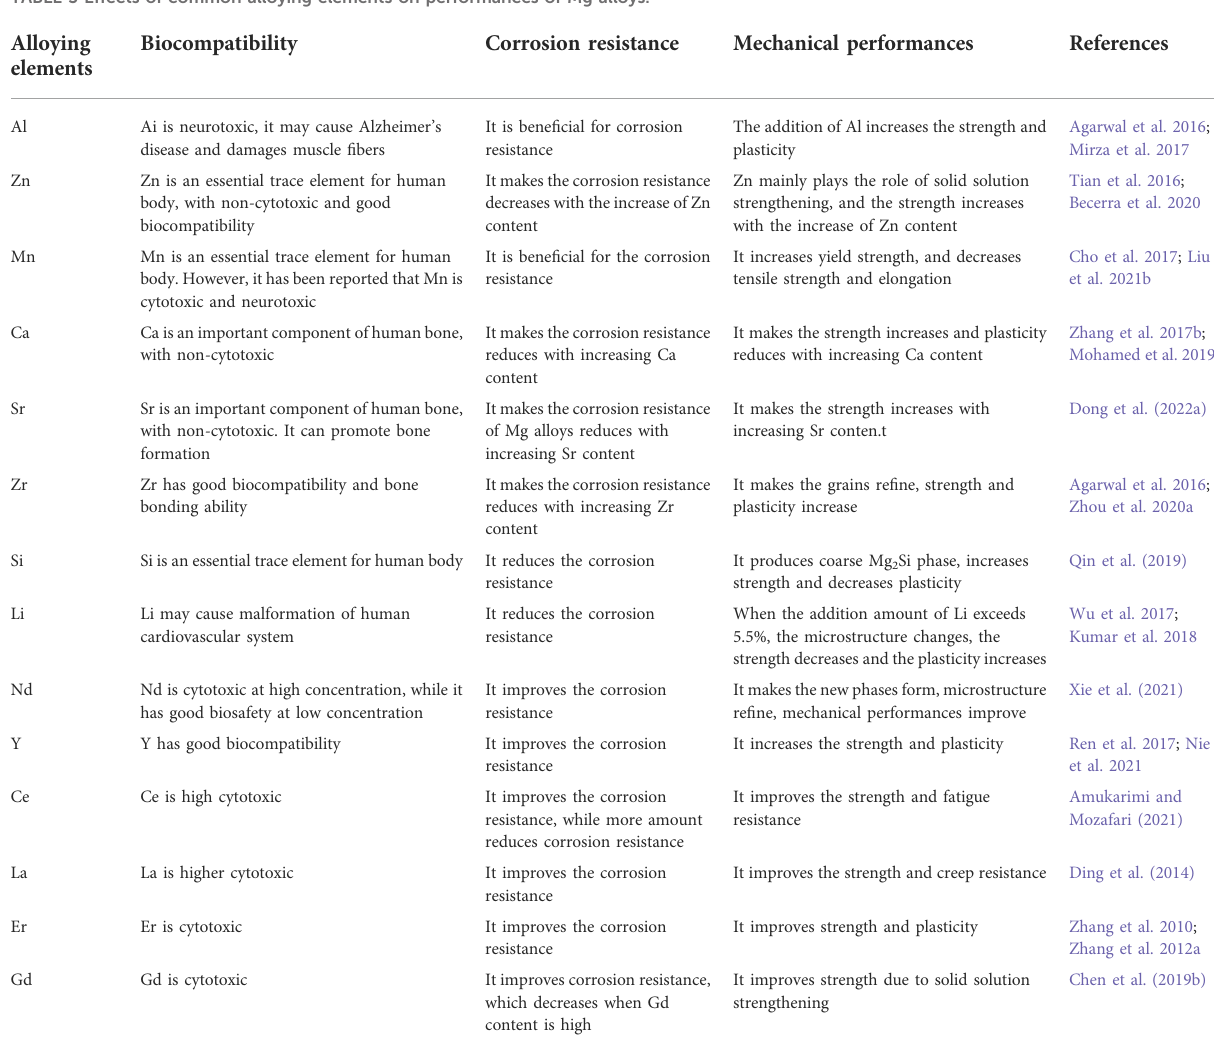
TABLE 3 Effects of common alloying elements on performances of Mg